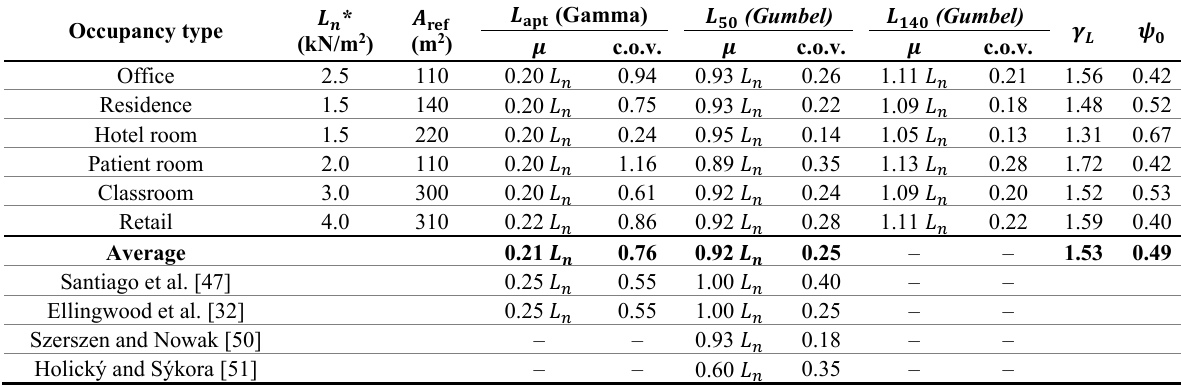
with increasing influence area . 𝛾𝛾 𝐿𝐿 𝛿𝛿 for specific reference areas and comparison 𝛿𝛿 ref 𝛾𝛾 𝐿𝐿